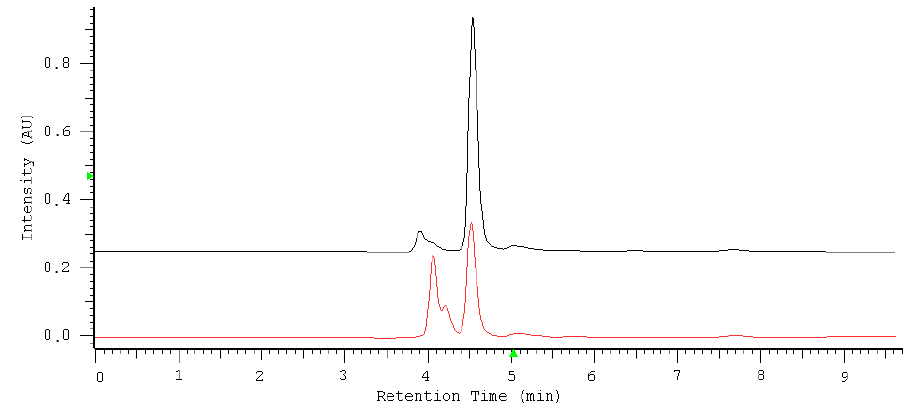
Figure 8. The overlapped chromatograms representing saliva with spiked nitrate and nitrite at a concentration level of 15 µg mL − 1 without an oxidation reaction (red line) and saliva with spiked nitrate and nitrite after the oxidation reaction (black line).